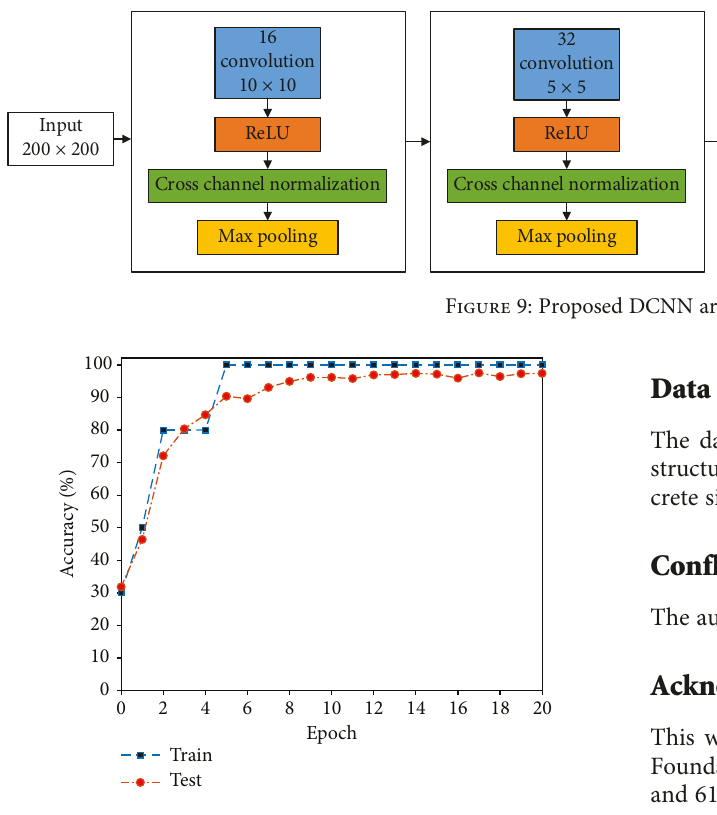
Figure 10: Test accuracy of the proposed DCNN. Table 5: Confusion matrix using DCNN.